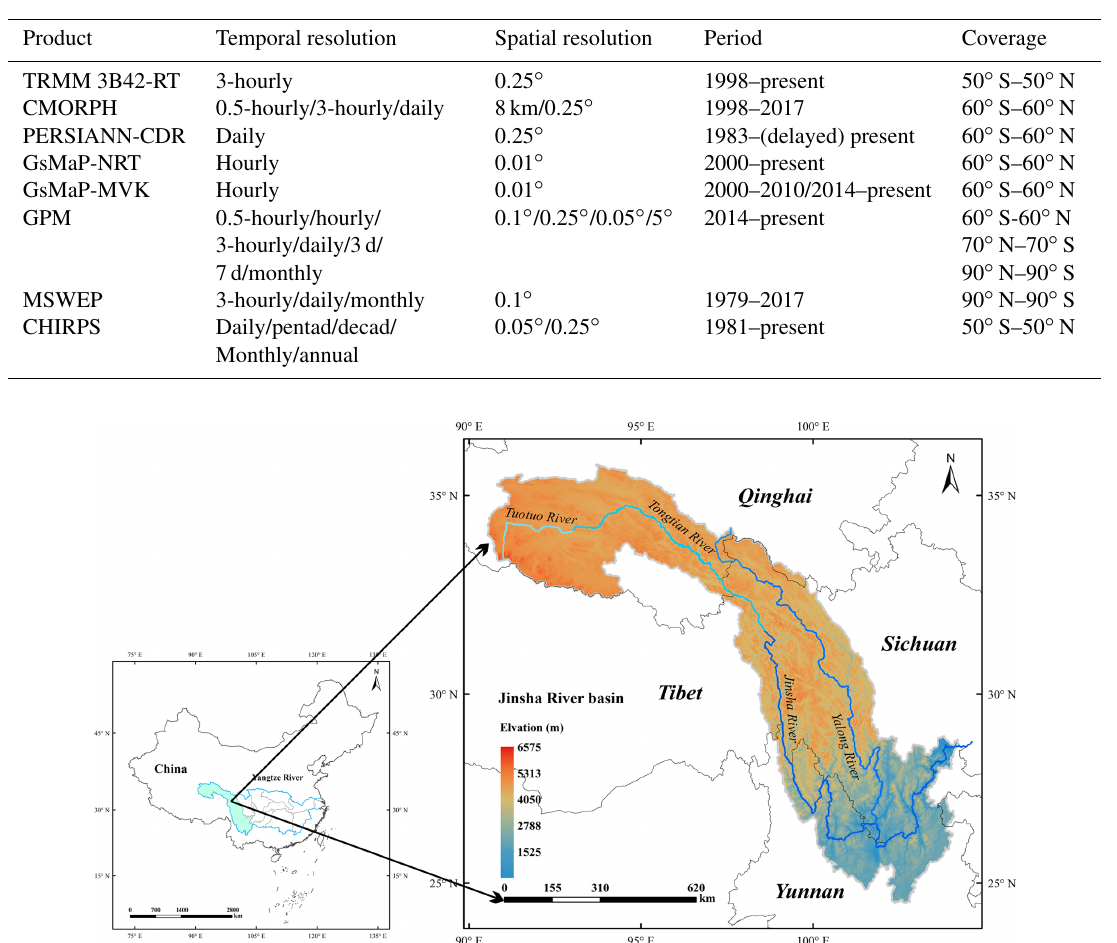
Table 1. Coverage and spatio-temporal resolutions of major satellite precipitation datasets.